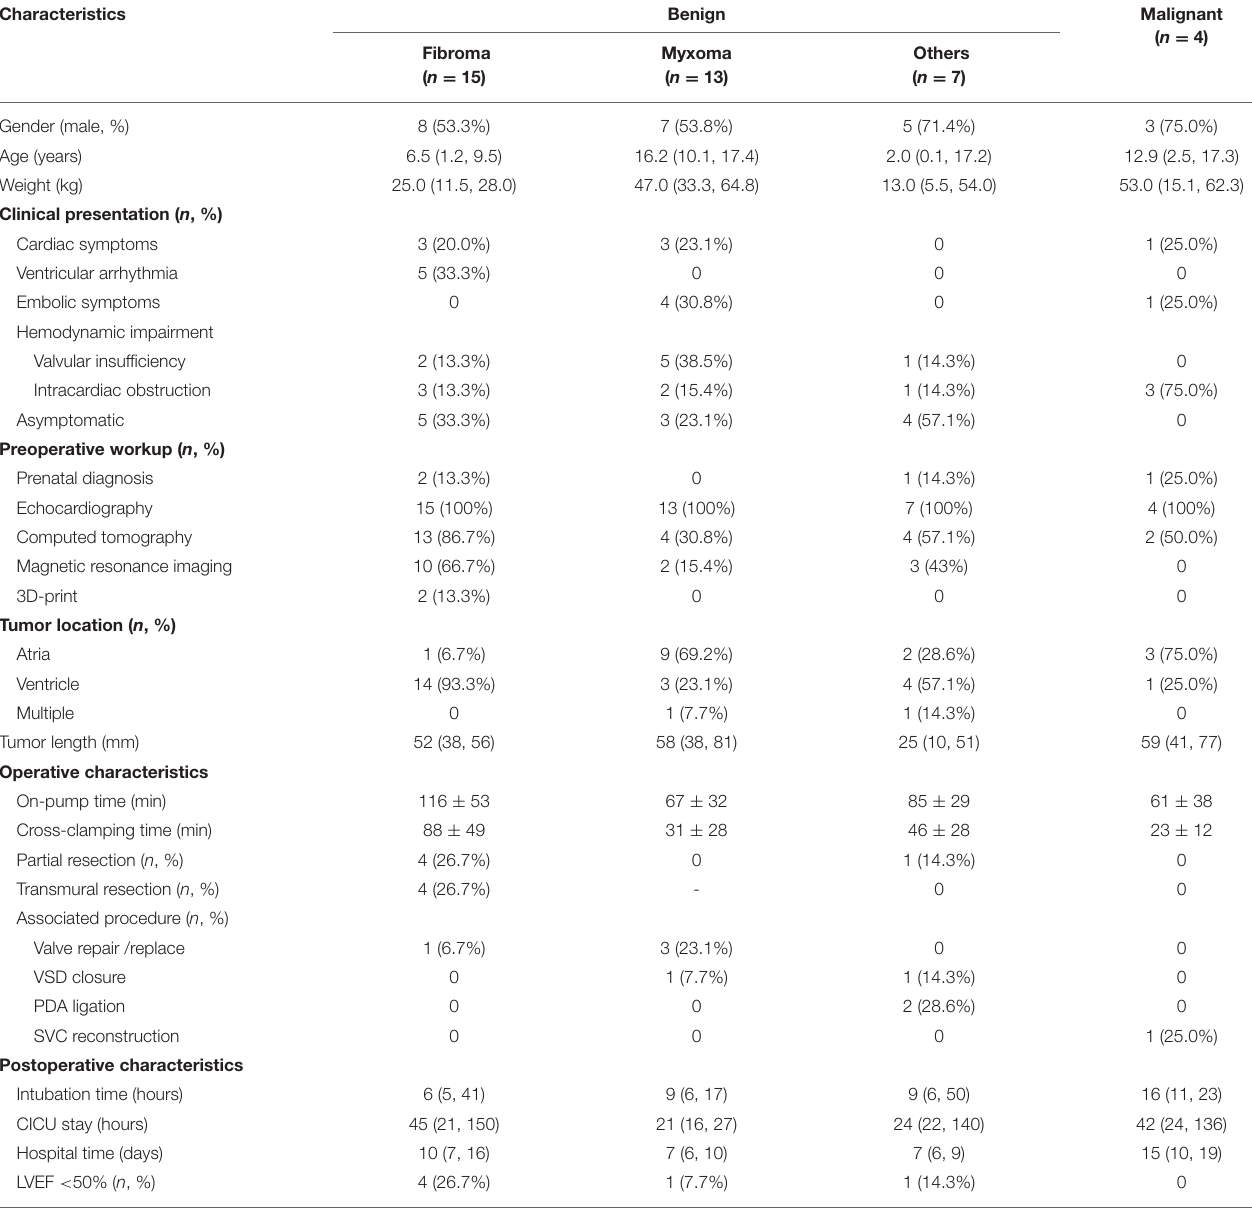
TABLE 1 | Characteristics for 39 patients with primary cardiac tumors. Characteristics